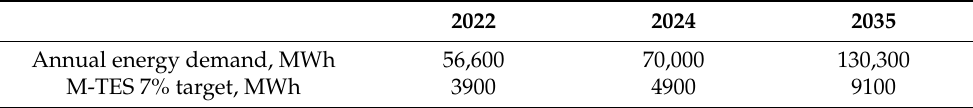
Table 1. The Surrey City Energy projected annual